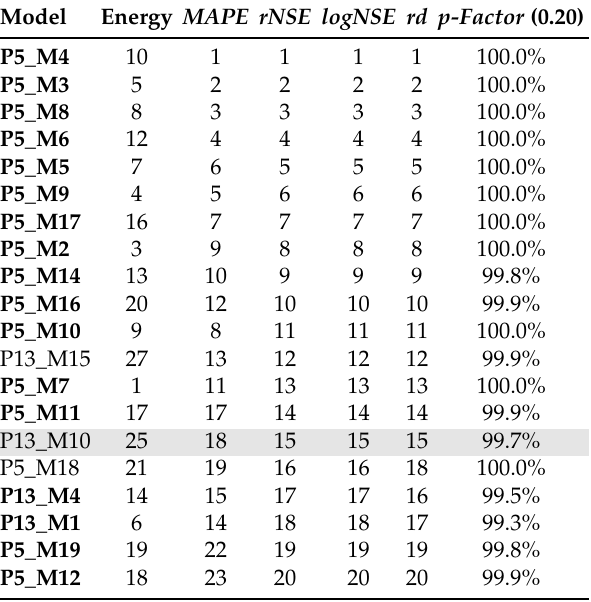
Table 11. (Synthetic case) Ranking ascending by logNSE . The text in bold corresponds to the models with the lowest energy consumption. The row shaded in gray corresponds to the best model selected by the old methodology.